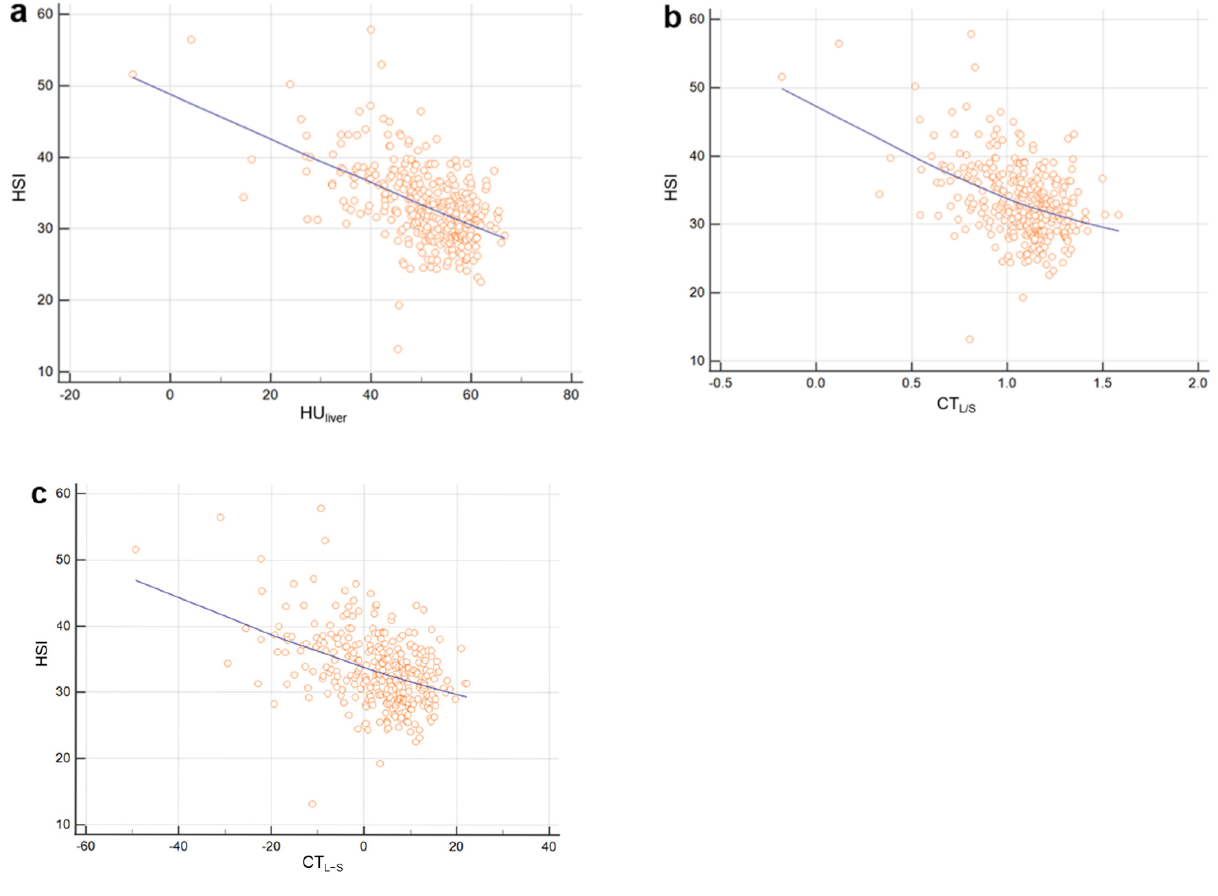
Figure 3. Scatter plots of HSI level as a function of HU liver ( a ), CT L/S ( b ), and CT L-S ( c ). Solid lines represent best-fit linear regression. HSI showed moderate negative correlation with criterion ( a ) (Spearman’s coefficient of rank correlation rho ( r ) = − 0.531) and showed weak negative correlations with criteria ( b ) and ( c ) ( r = − 0.436 and − 0.437, respectively).